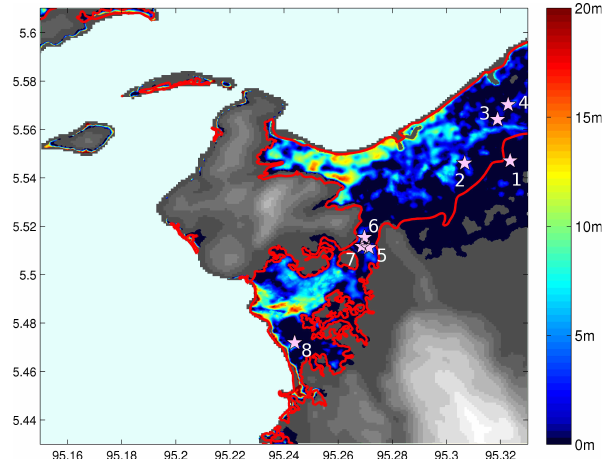
Fig. 9. Positions of field measurements and flowdepth obtained with Manning number n = 0 . 03 and original Tanioka source. The red line indicates the inundated area as it was determined from satellite im- ages by